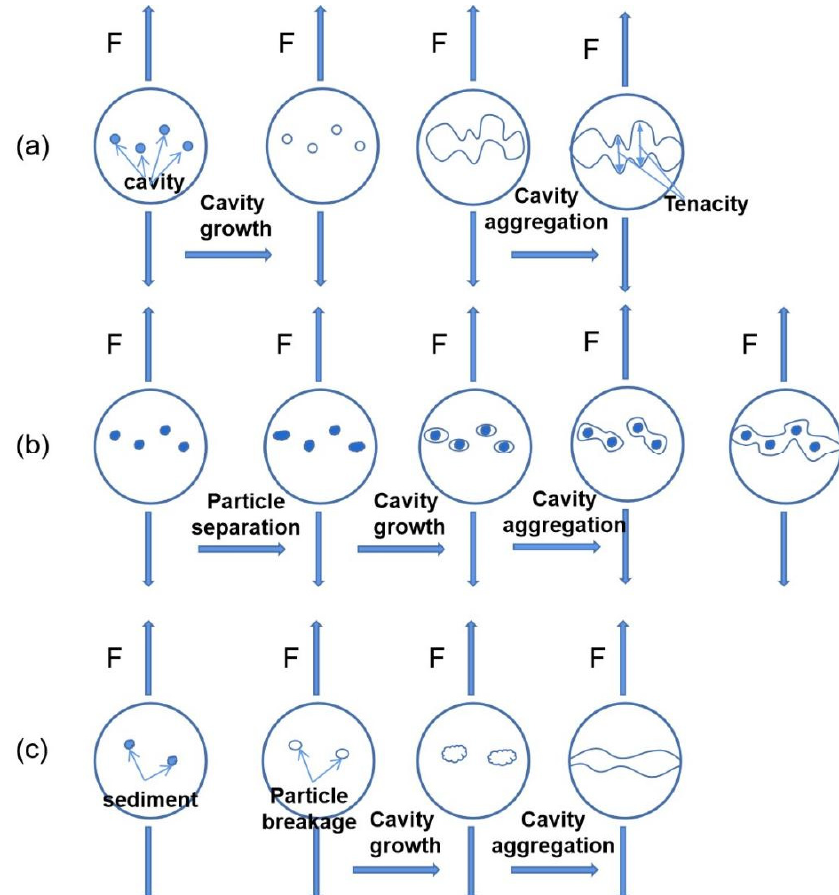
Figure 13. Formation mechanism of fatigue dimple: ( a ) cavity growth, ( b ) separation of second-phase particles, ( c ) fragmentation of second-phase particles.